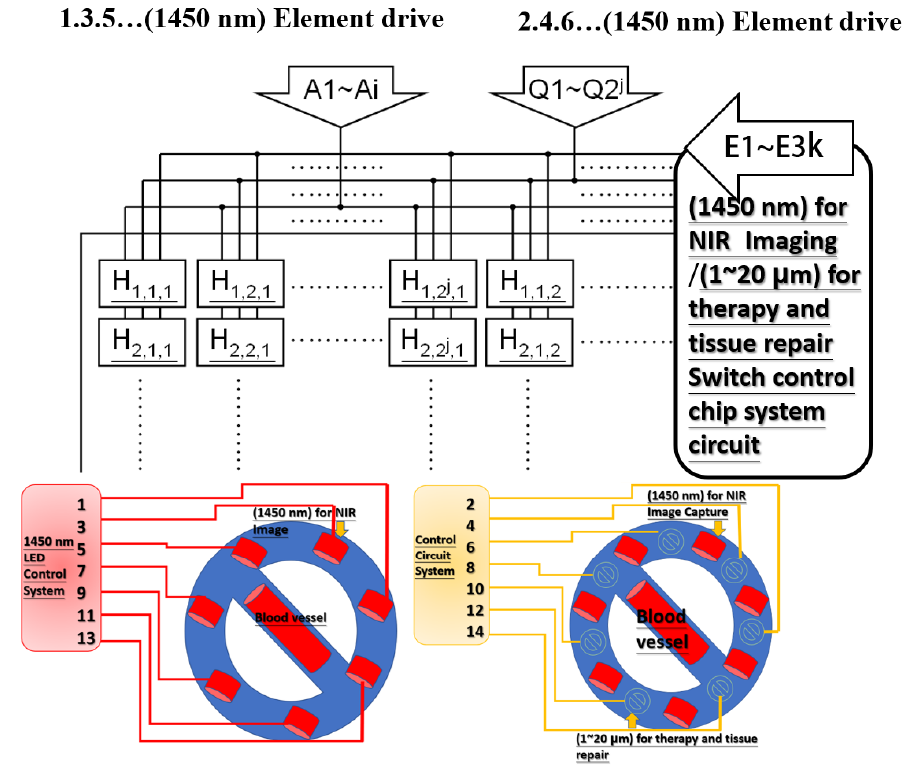
Figure 1. Switching control system circuit of 1450 nm for near-infrared (NIR) imaging (1–20 µ m), which can be used for therapy and tissue repair.